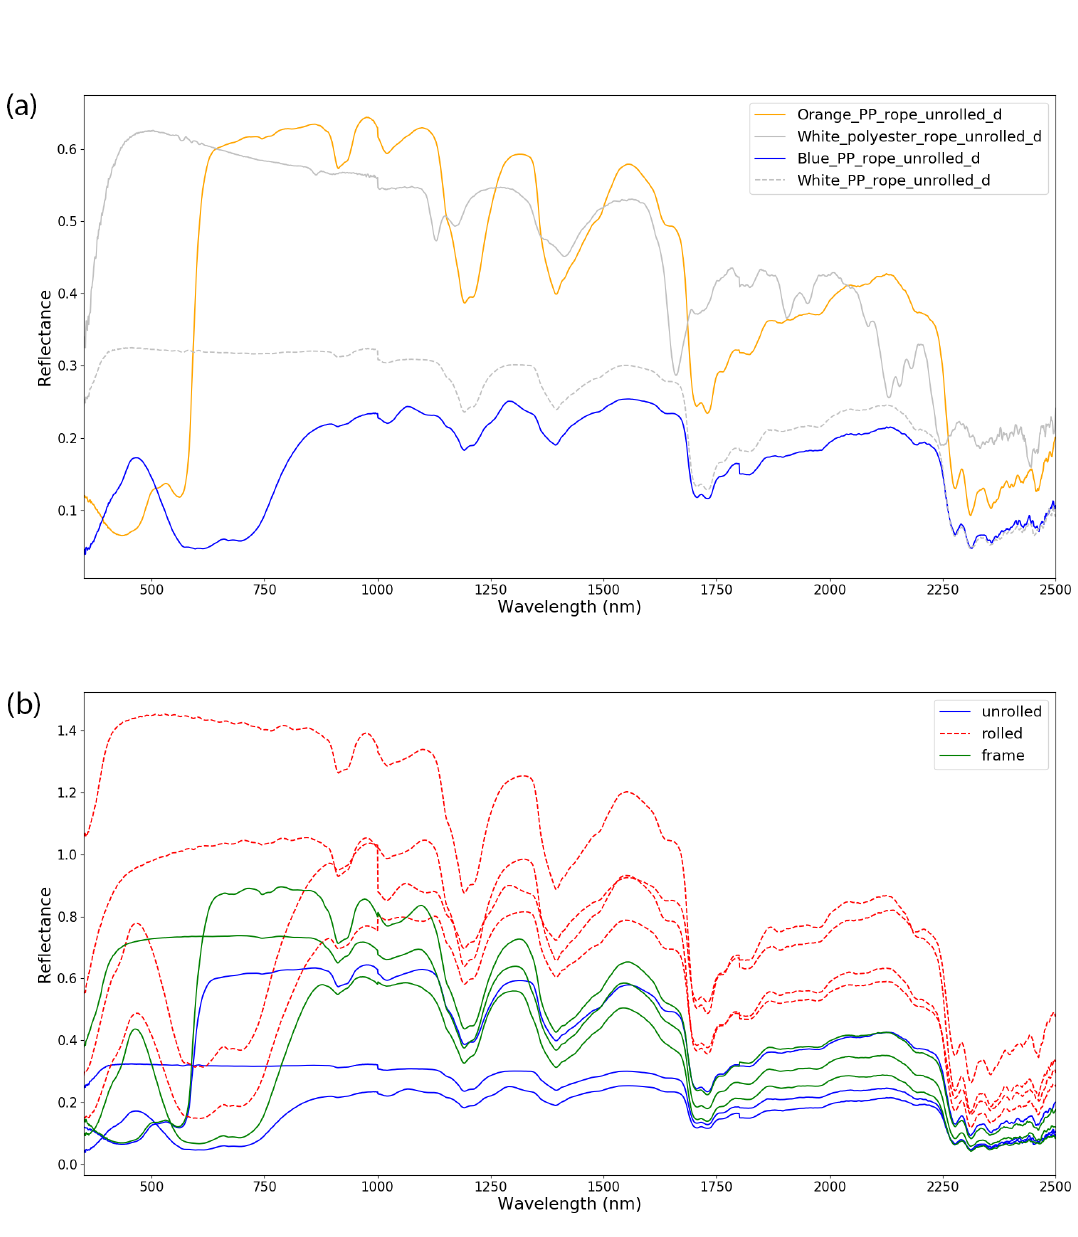
Figure 7. Spectral reflectance of dry ropes; (a) white, orange and blue rope; and (b) all ropes in different conditions: on a roll as bought in the store, unrolled and aligned on a plexiglass